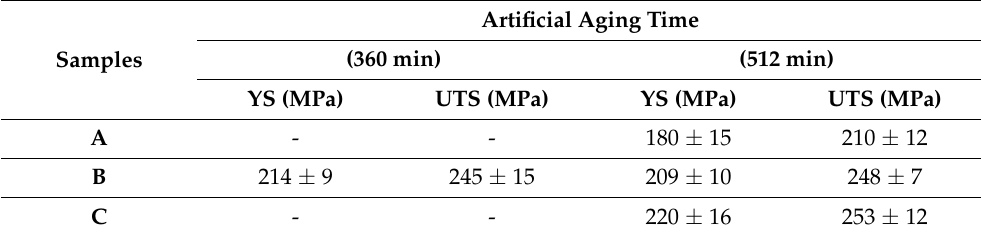
Table 3. Processing conditions of the